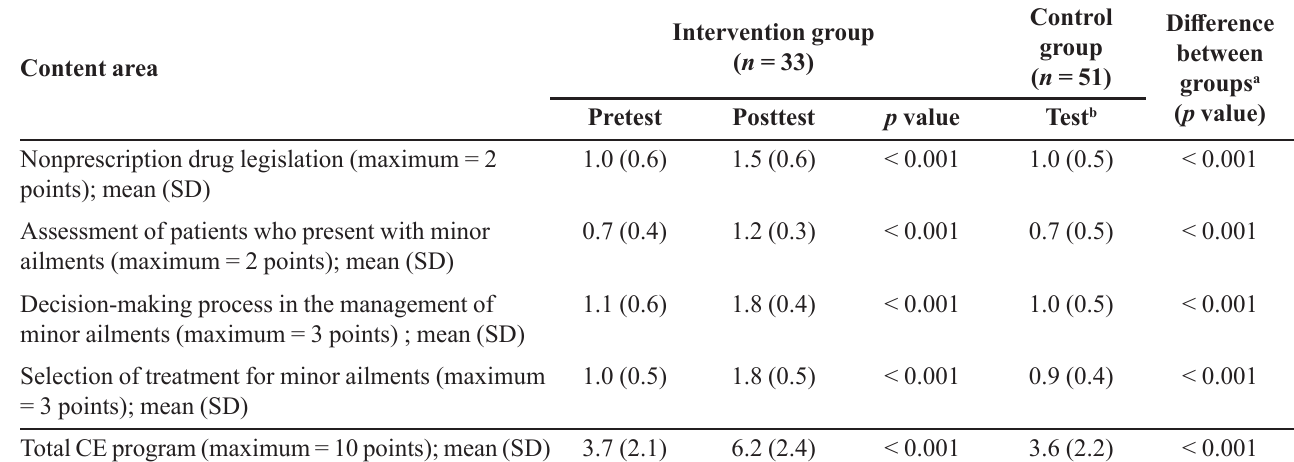
Intervention group ( n = 33)